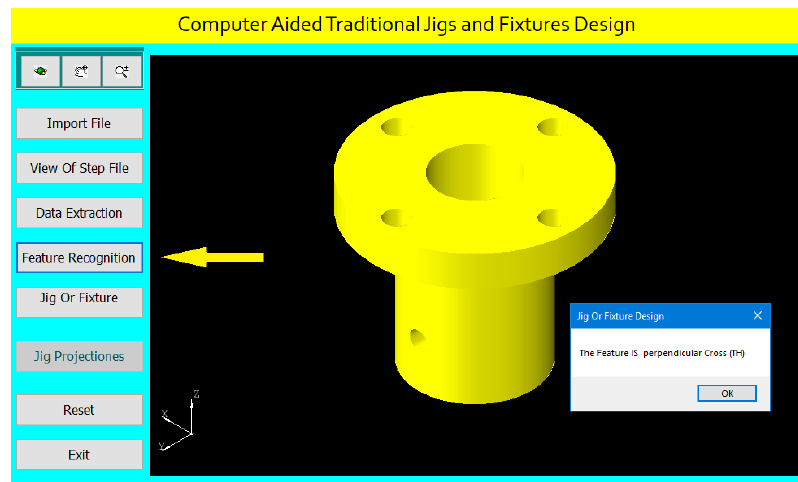
Figure 13. The fourth screen of the system interface.